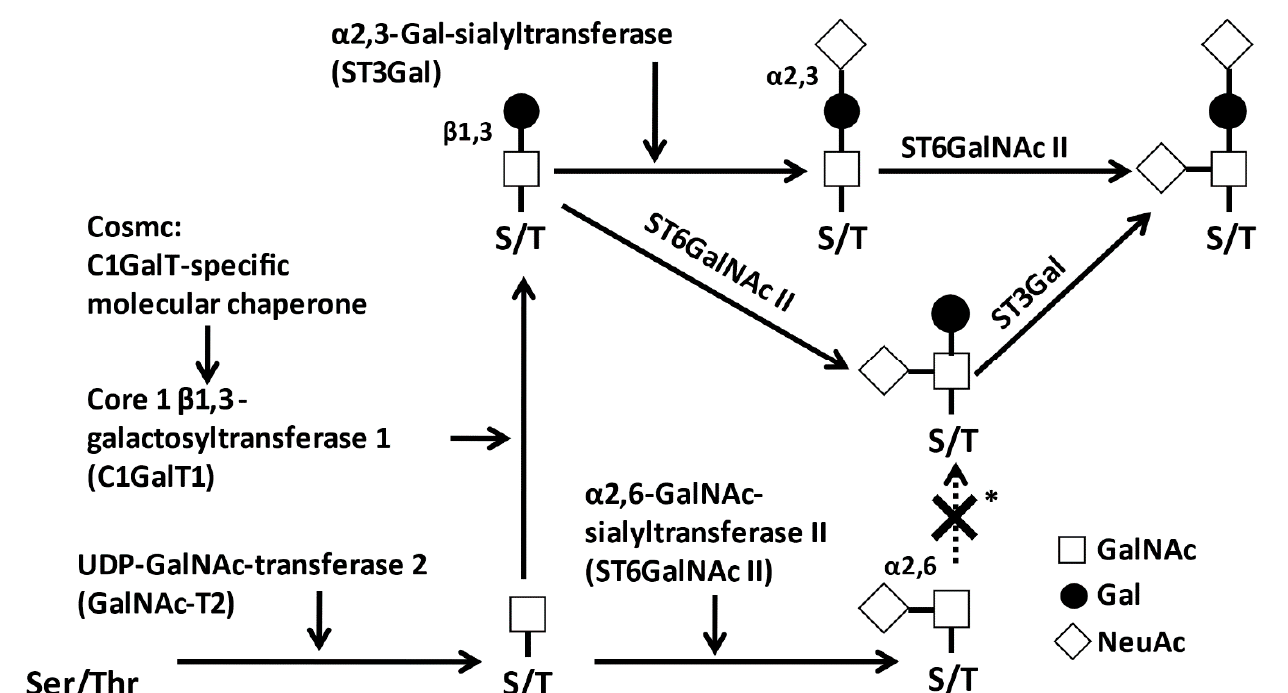
Figure 3. O -Glycosylation pathways of the human IgA1 hinge region (HR). The biosynthesis process starts with the attachment of N -acetylgalactosamine (GalNAc) to Ser/Thr residues in the HR by UDP-GalNAc-transferase 2 (GalNAc-T2). GalNAc residues are extended by galactose or N -acetylneuraminic acid (NeuAc) by core 1 β 1,3-galactosyltransferase (C1GalT1) and its molecular chaperone Cosmc or α 2,6 sialyltransferase (ST6GalNAc2), respectively. Finally, the O -glycan structure is completed by attachment of NeuAc to the galactose residue and/or GalNAc residues, each of which is mediated by α 2,3-sialyltransferase (ST3Gal1) and ST6GalNAc2. The sialylation of GalNAc before the attachment of galactose prevents galactosylation of GalNAc (marked by *) [62].